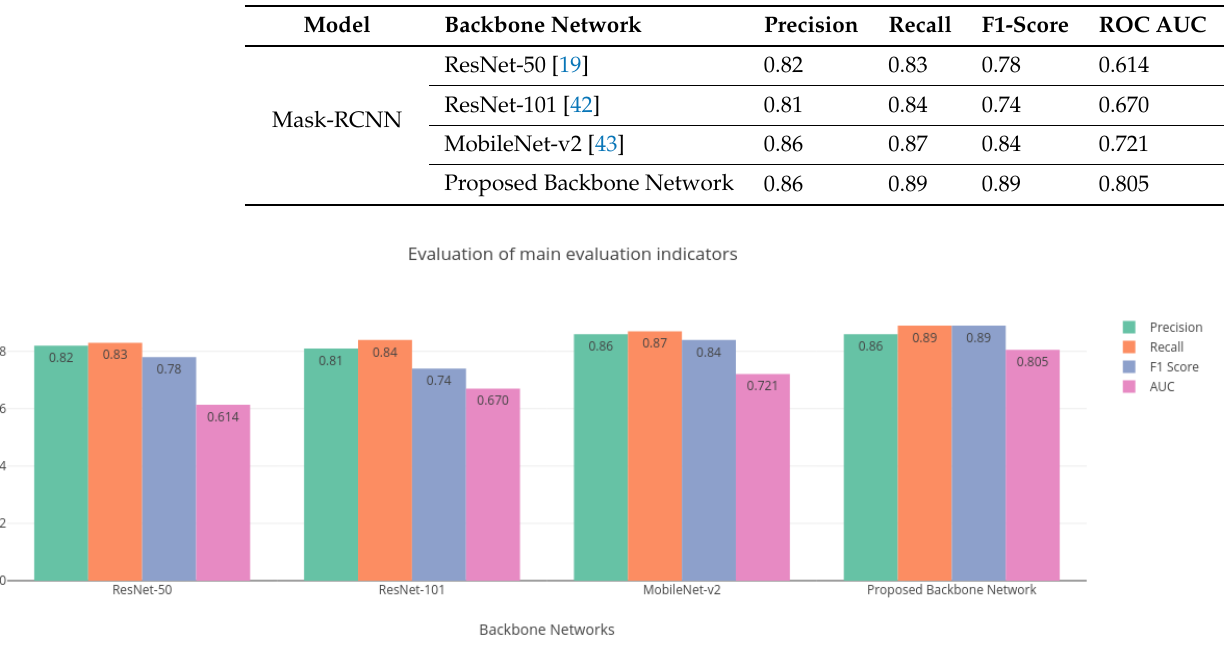
Table 3. Comparison of M-RCNN with different backbone networks.